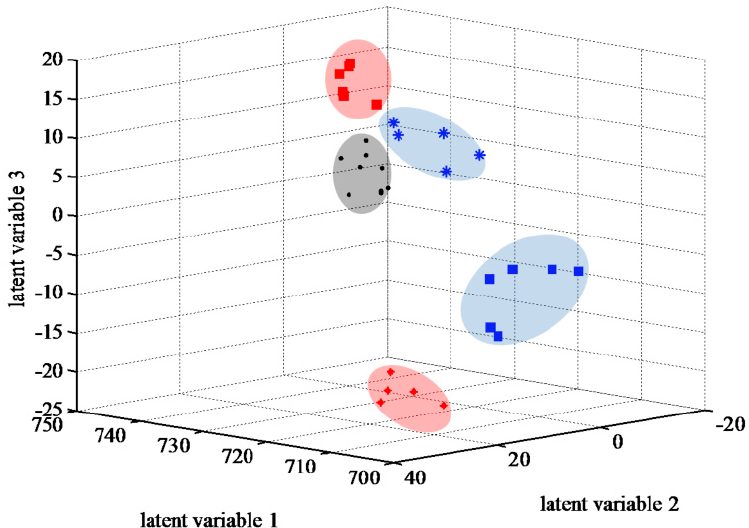
Figure 4. Score plot obtained by partial least square discriminant analysis (PLSDA). Four distinct groups of samples were